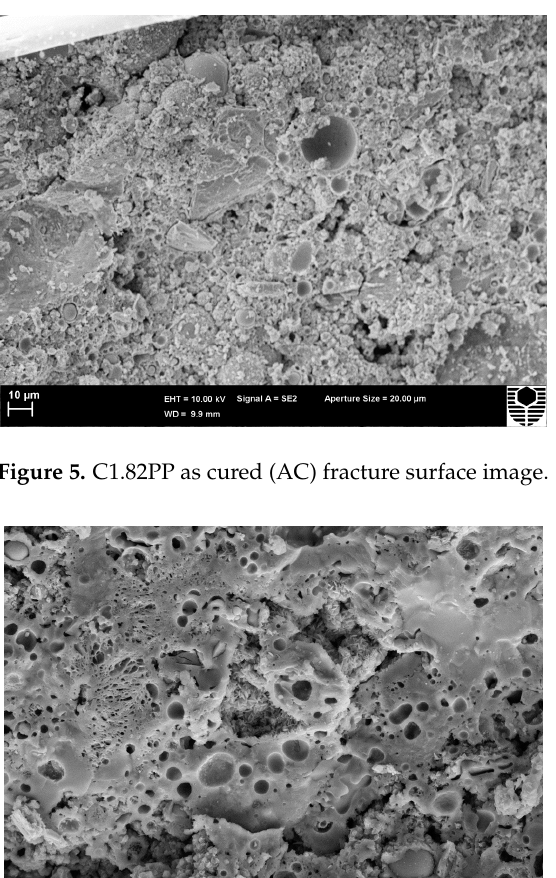
Figure 6. C1.82PP post compression test at 500 °C image.